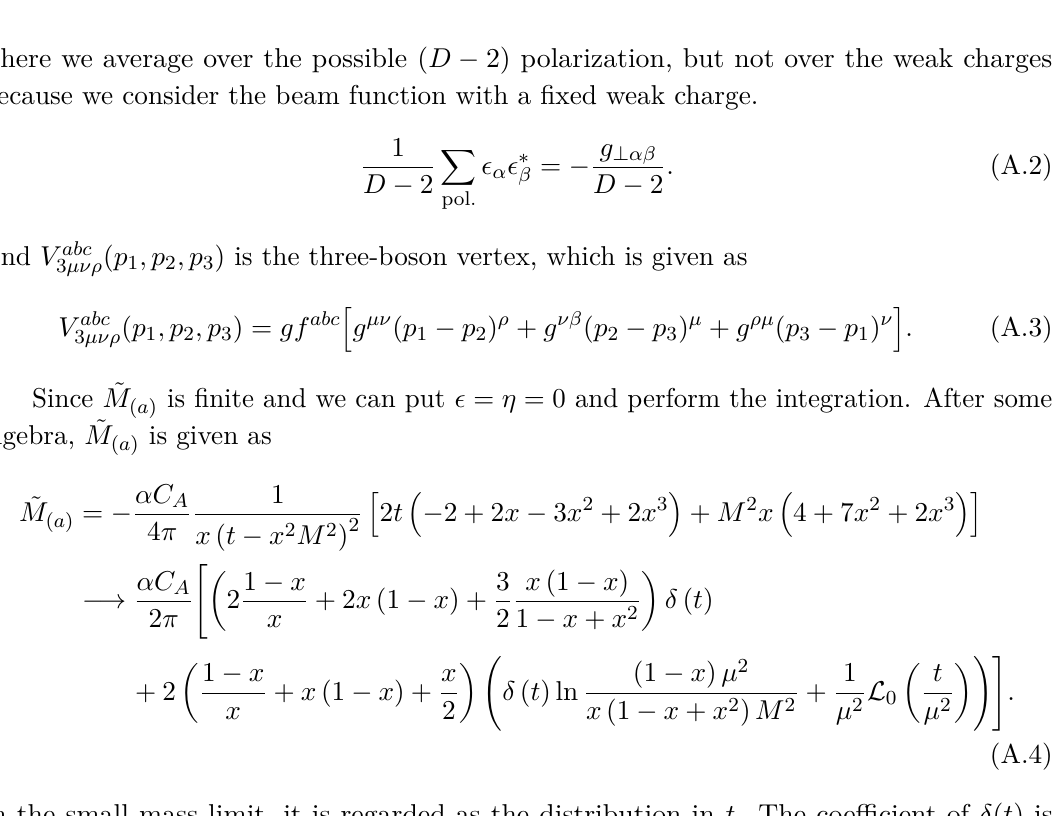
with one and two gauge n ⊥